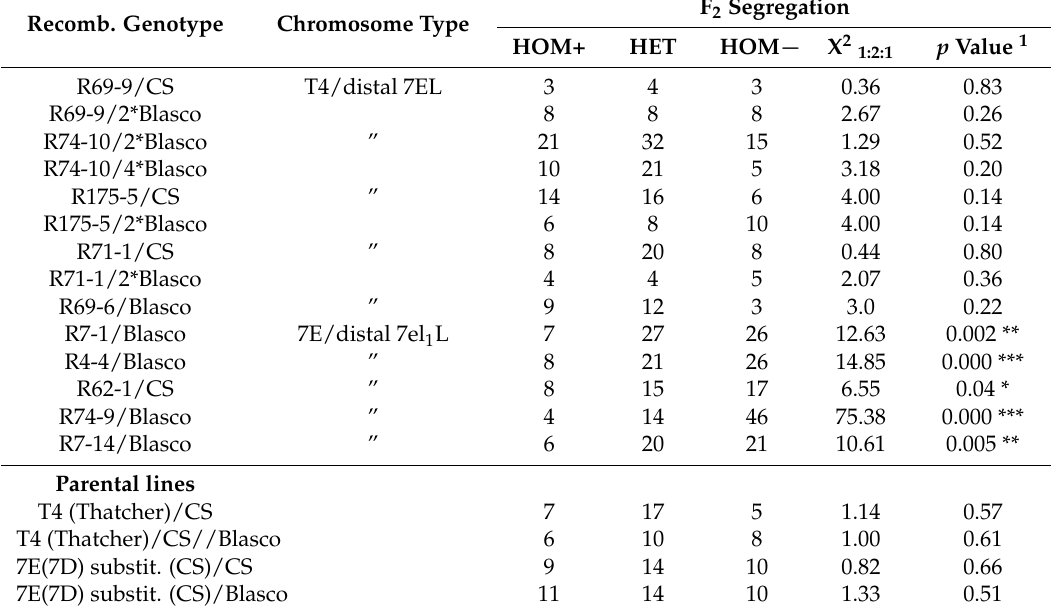
Table 4. Segregation ratios in F 2 progenies from the cross of 7E/7el 1 recombinants and parental lines (T4 and the 7E(7D) substitution line), taken as control, with normal bread wheat cultivars (CS or Blasco). Maps of recombinant chromosomes are reported in Figure